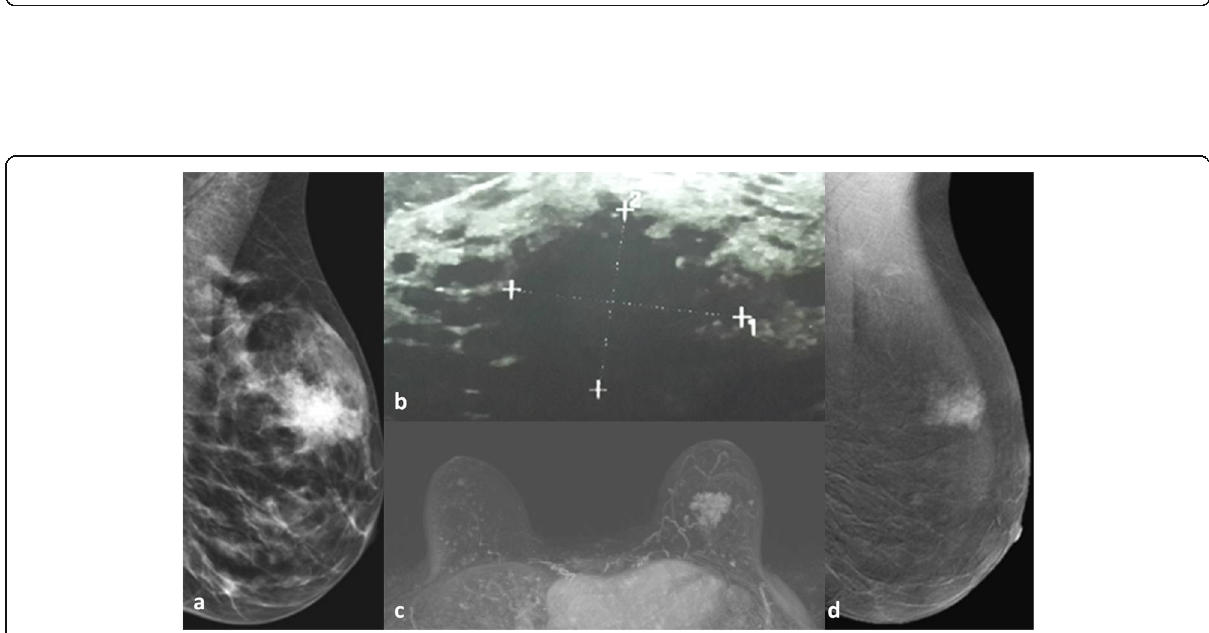
Fig. 3 Thirty-one-year-old patient presented by left nipple erosions. SM revealed left breast multiple groups of microcalcification ( a , b ). CEM showed no significant contrast uptake ( c ). MRI showed left nipple/areola complex thickening with intense enhancement and associated intense ductal enhancement; on plotting the time-intensity curves, they showed type I (rising curve) and type II (plateau curve) enhancement curves ( d , e ).The final diagnosis was Paget ’ s disease of the nipple with associated high-grade DCIS